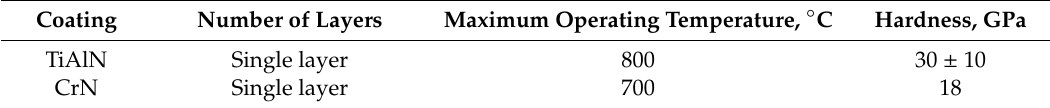
Table 2. Characteristics of physical vapor deposition (PVD) coatings [27,41–46].